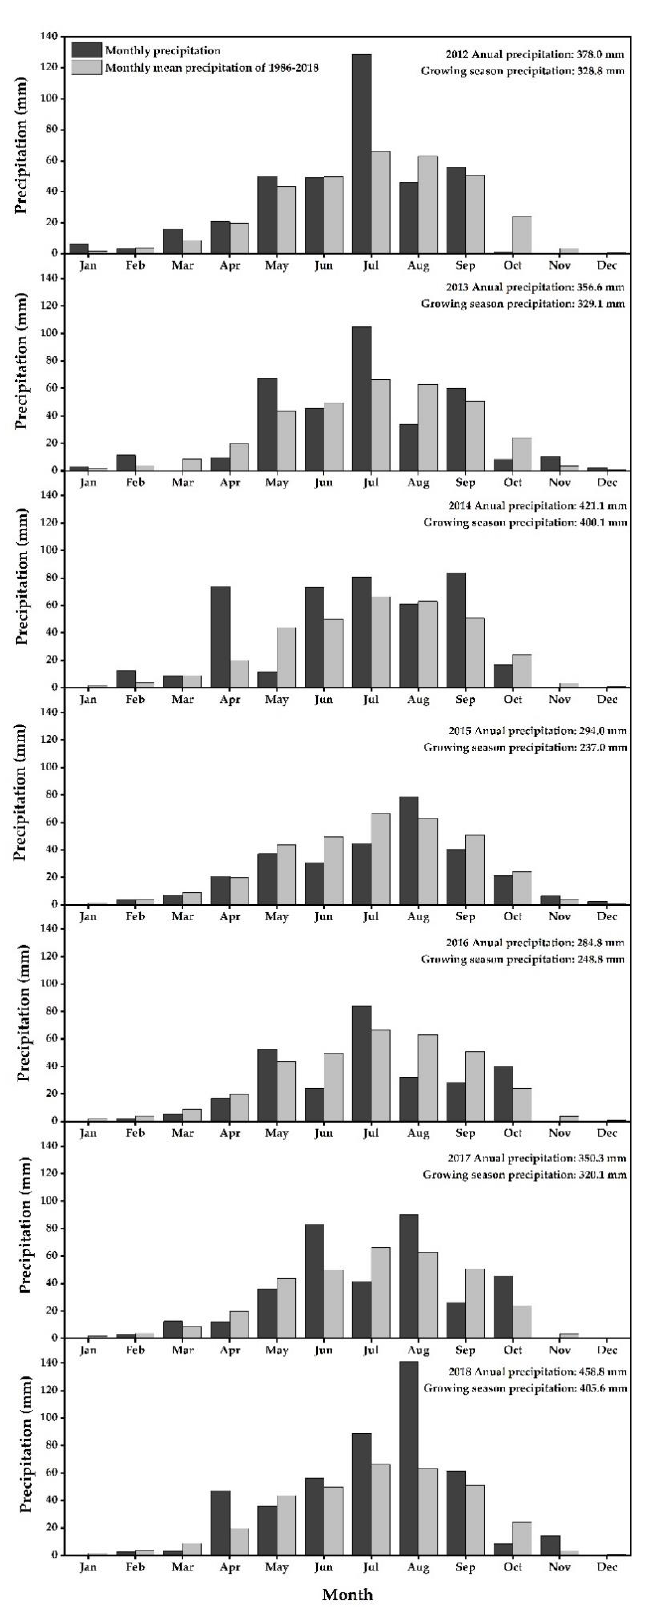
Figure 2. Annual growing season and monthly precipitation of the experimental years and of the past 33 years (1986–2018) at the study site.